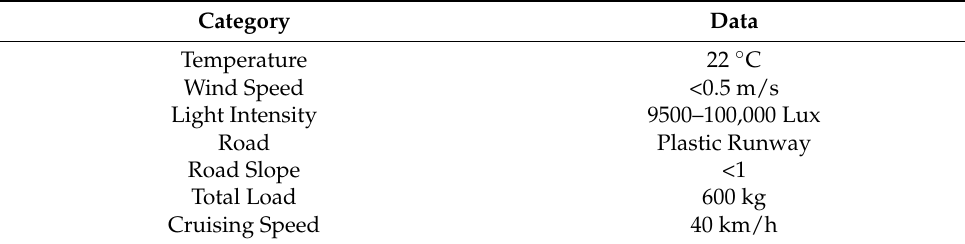
Table 4. Experimental